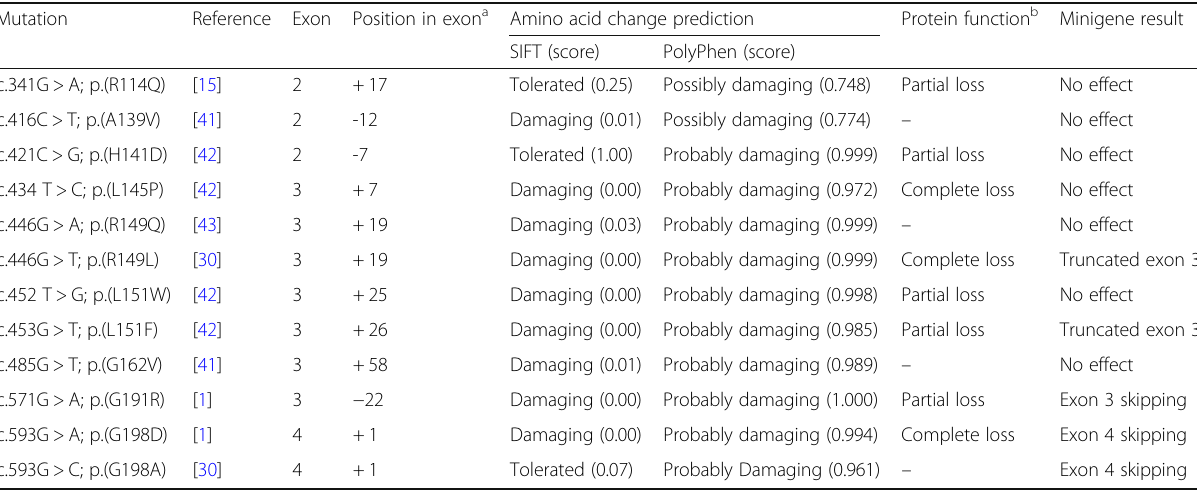
Table 1 Claudin-16 exonic mutations selected for this study and their effects